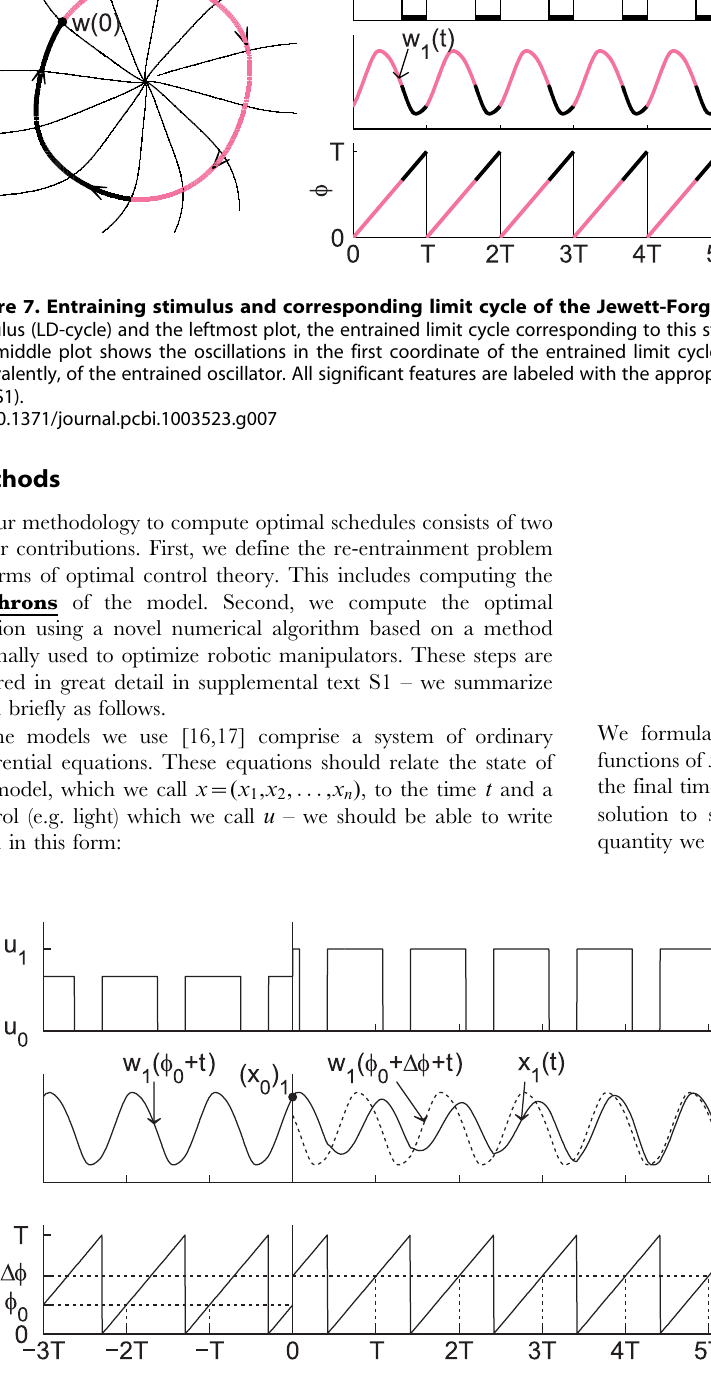
Figure 8. The process of re-entrainment to a phase shift of the Jewett-Forger-Kronauer Model. The top plot shows the entraining stimulus (LD-cycle) to the oscillator, plotted on a log scale, shifted by D w hours at time 0. The light level increases from 100 lux before time 0 to u 1 (=10,000 lux) after time 0. In this case D w (=7 hours) is positive, so the schedule is advanced. The middle plot shows the oscillations in first coordinate of the model. The entrained oscillator before the phase shift is shown with a solid line, and the dotted line shows how the oscillator would behave were it entrained to the shifted stimulus. The solid line after time 0 shows the process of re-entrainment to the phase shift. The last plot shows the phase of the stimulus or, equivalently, of the entrained oscillator. Notice that the shift takes place when the phase of the stimulus (and therefore of the entrained oscillator) is w 0 (=7 hours). All significant features are labeled with the appropriate notation (See Methods, or Setting up the Problem in supplemental text